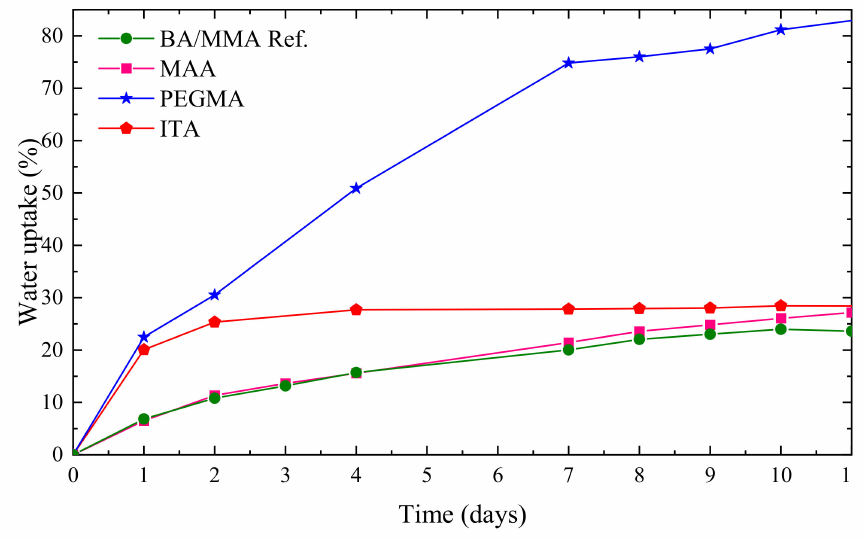
Figure 5. Water uptake curves for the films prepared with THP annealed 24 h at 60 ◦